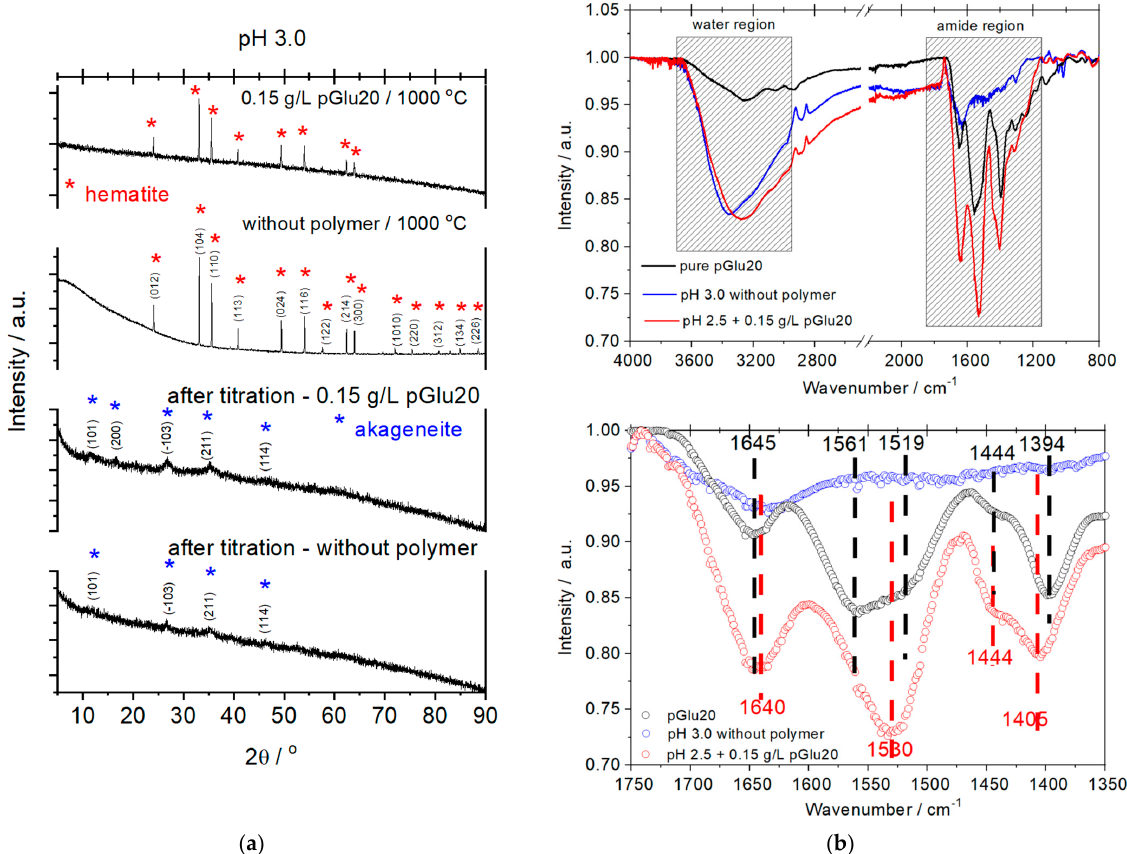
Figure 3. ( a ) XRD patterns of powders drawn after titrations at pH 3.0 and after the non-isothermal TG/DTA analysis up to 1000 °C. ( b ) FTIR spectra of the as-received pGlu20 powder and the reference Fe(III)-oxyhydroxide after titrations at pH 3 and the Fe(III) + 0.15 g/L pGlu20 sample after titration at pH 2.5 (upper panel) with a magnified amide region (lower panel).